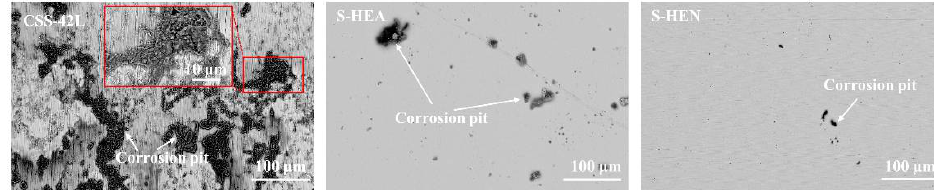
Figure 8. SEM images of CSS-42L and S-HEA/S-HEN after corrosion.